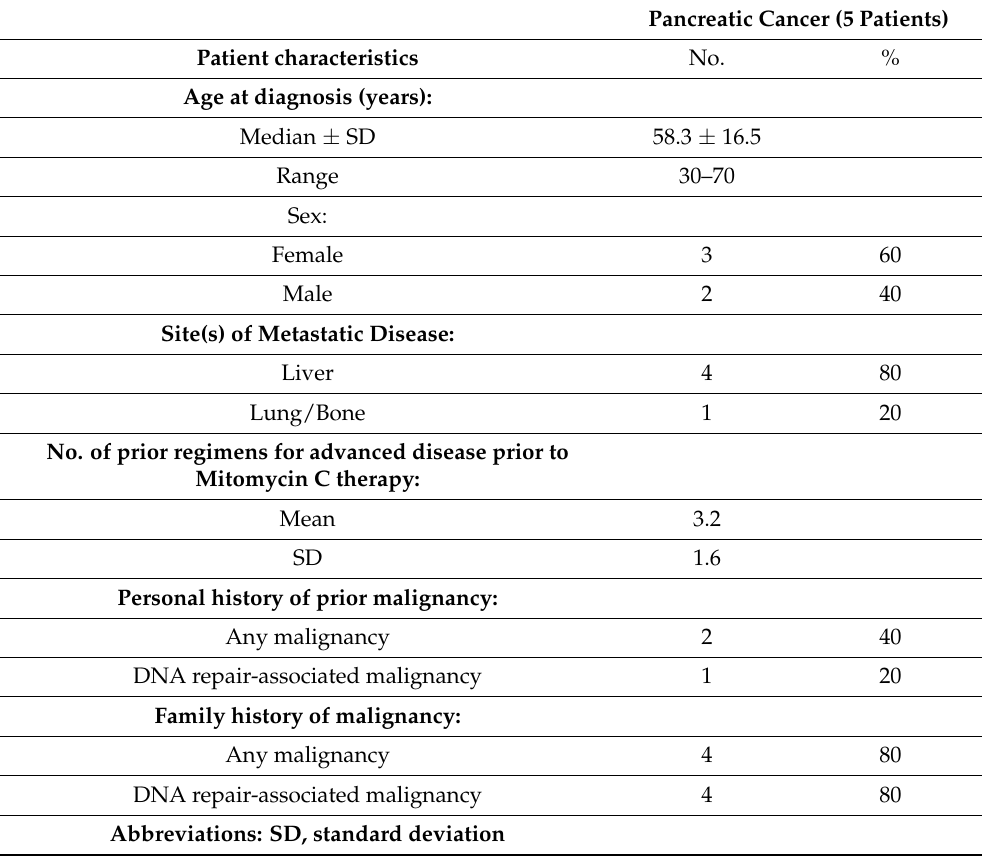
Table 1. Patient Demographic and Clinical